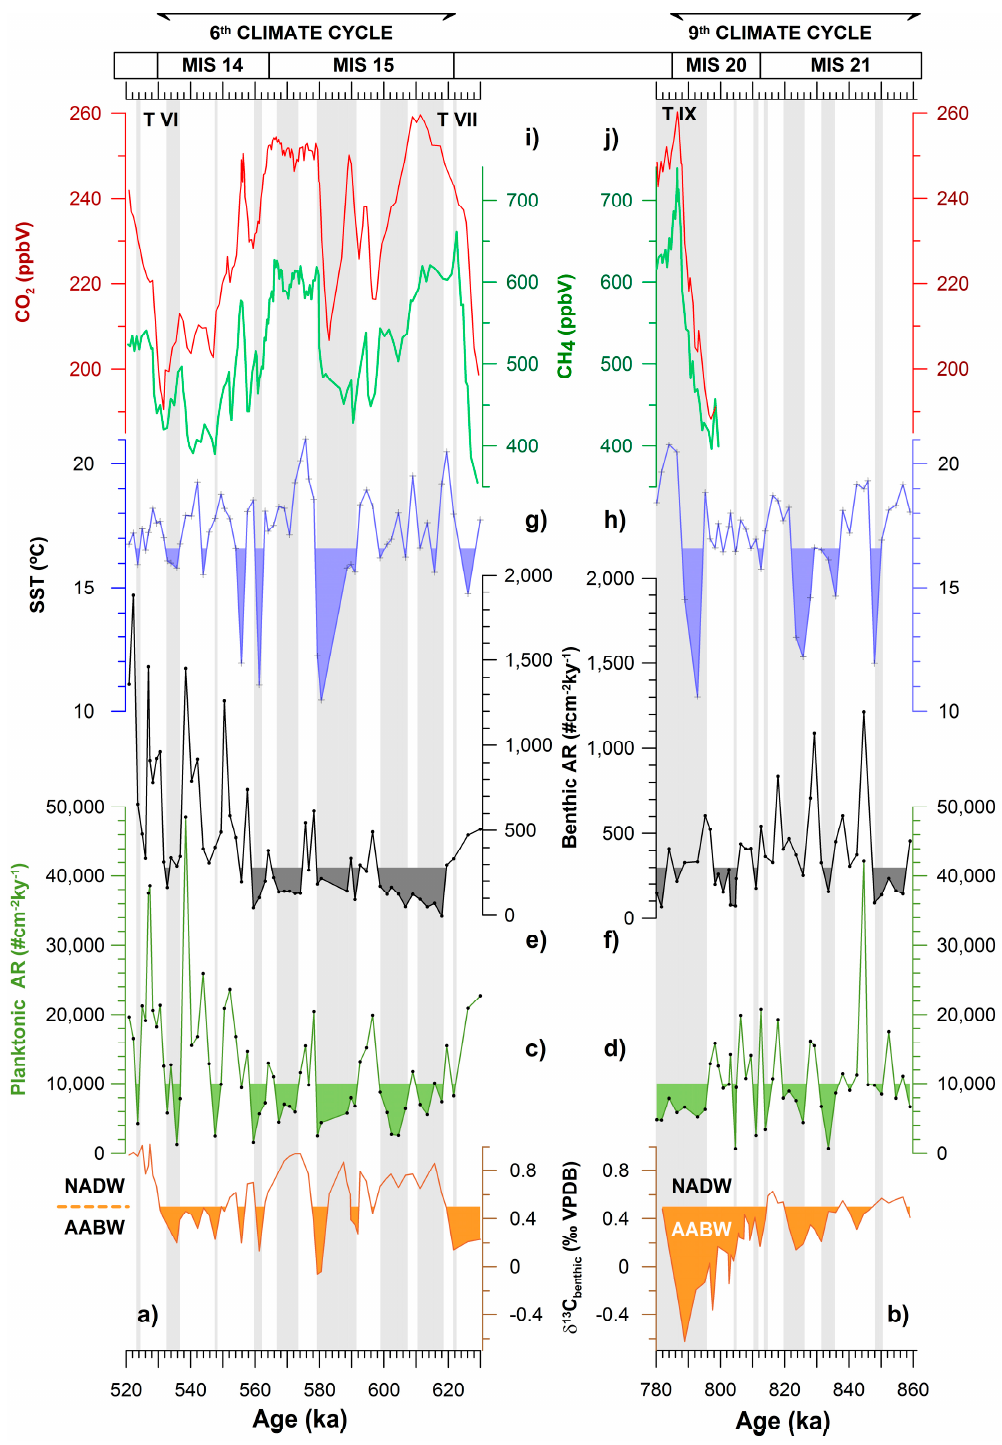
Figure 3. Records from site U1385 during the ninth and sixth climate cycles, compared with greenhouse gasses. ( a , b ) Benthic δ 13 C [41]; the fill enhances 13 C-depleted values typical for AABW [44]. The more negative the δ 13 C, the higher the boundary NADW/AABW is in the study site. ( c , d ) Planktonic foraminiferal Accumulation Rate (PAR) (#complete planktonic foraminifer shells/cm 2 ky). ( e , f ) BAR (#complete benthic foraminifer shells/cm 2 ky). ( g , h ) Annual Sea Surface Temperature (SST); the fill enhances values below 16.6 °C, which is the average SST for the study-interval. ( i , j ) CH 4 (green) [51] and CO 2 (red) [52] content in the Antarctic ice. Terminations are marked in roman numerals, and MISes are written on top of the figure. Grey bands highlight intervals of low CO 2 absorption.